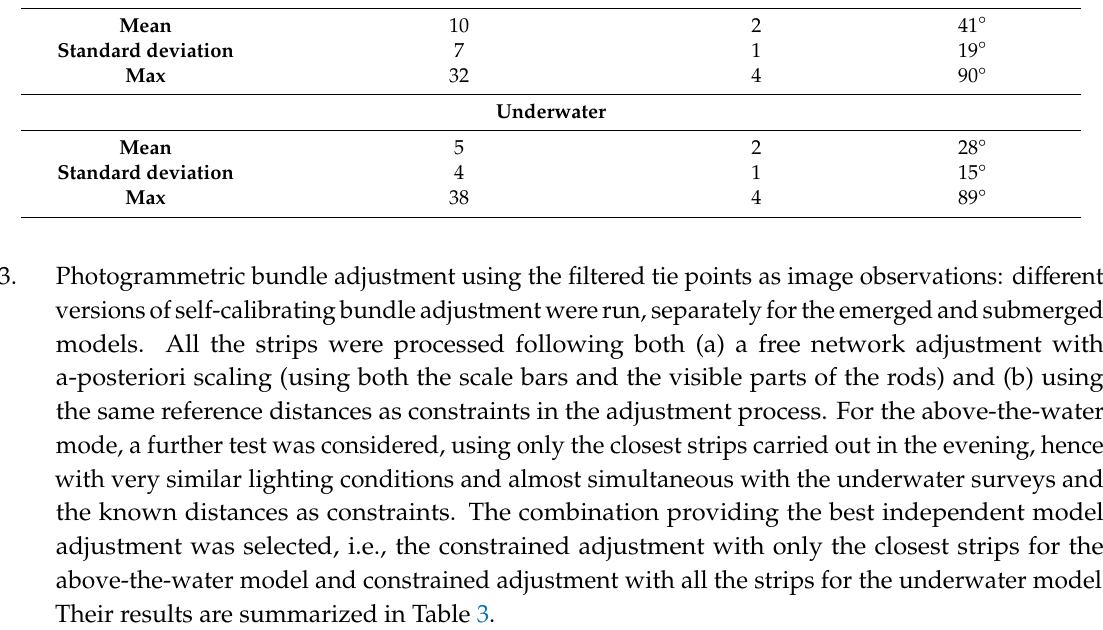
Statistics of the selected di ff erent bundle adjustment processes for the above and underwater survey.